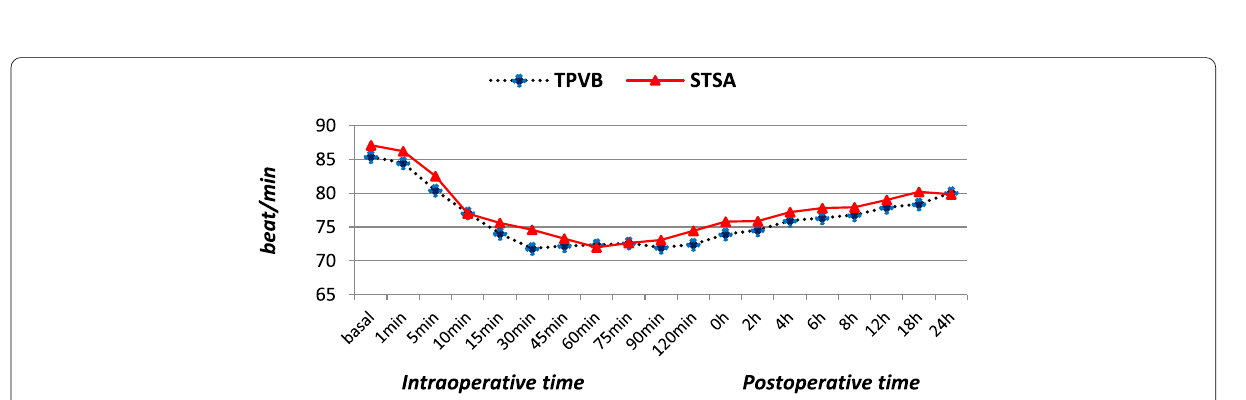
Fig. 3 Perioperative heart rate (beat/min) of the two studied